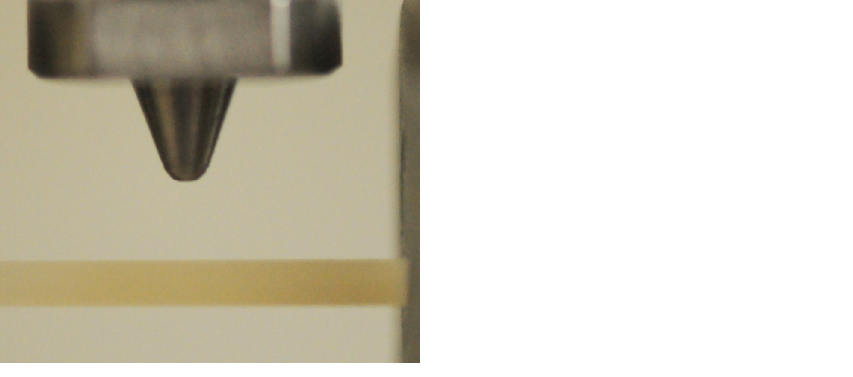
Figure 2. A prismatic-shaped specimen from the G-PMMA group, ready to be subjected to the three-point bending test.